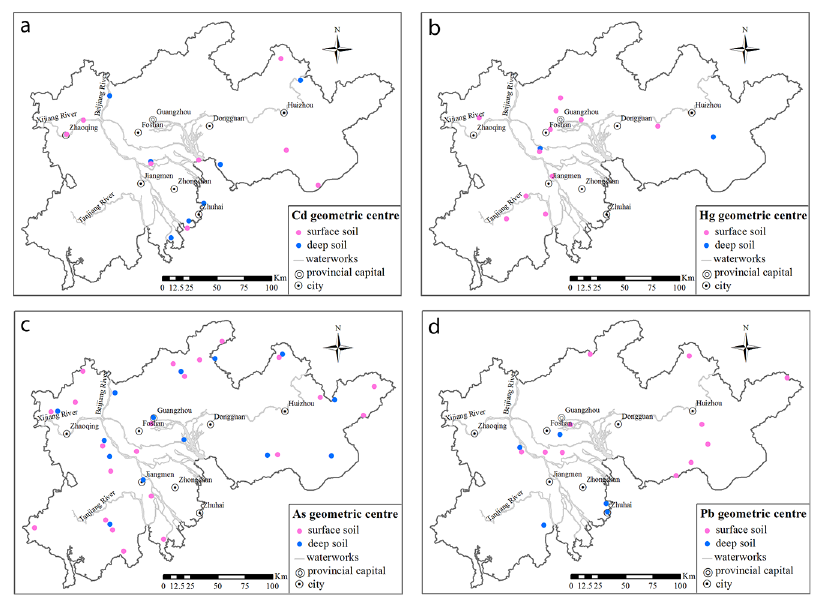
doi:10.1371/journal.pone.0132040.g005